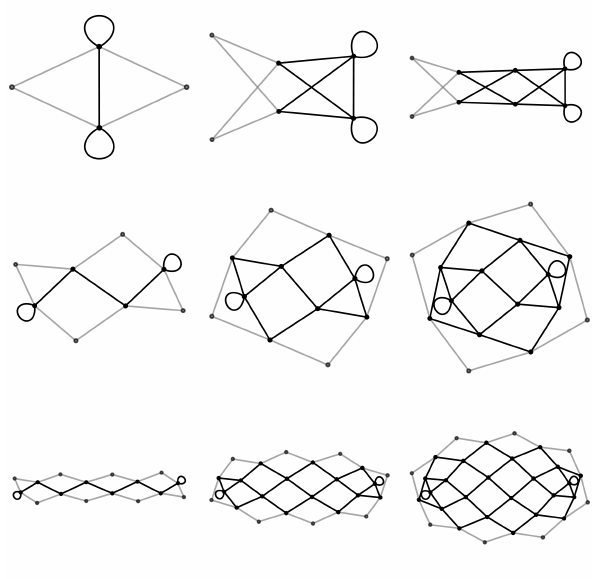
Figure 14. The nested nature of the primes. A p for p = 2 · q ( top row ), p = 2 2 · q ( middle row ) and p = 2 3 · q ( bottom row ) where q = 3,5, 7. In each case, the graph for a prime has a subgraph equal to the previous prime. This continues for higher